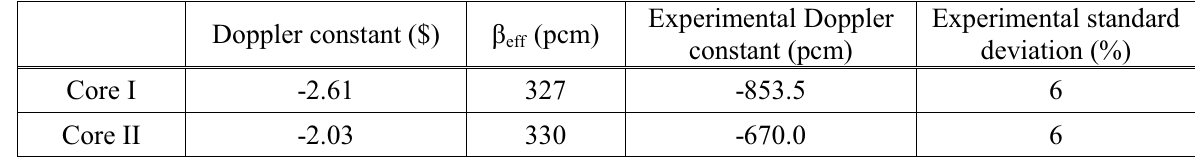
Table I. Reevaluated Experimental Doppler constant by Hazama &